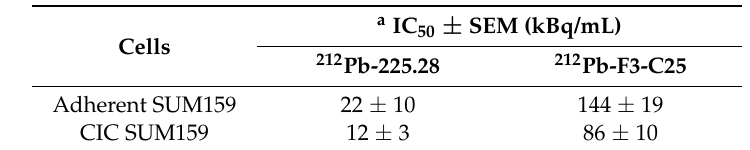
Table 2. In vitro inhibition of SUM159 cells and CIC clonogenic survival by 212 Pb-225.28 or 212